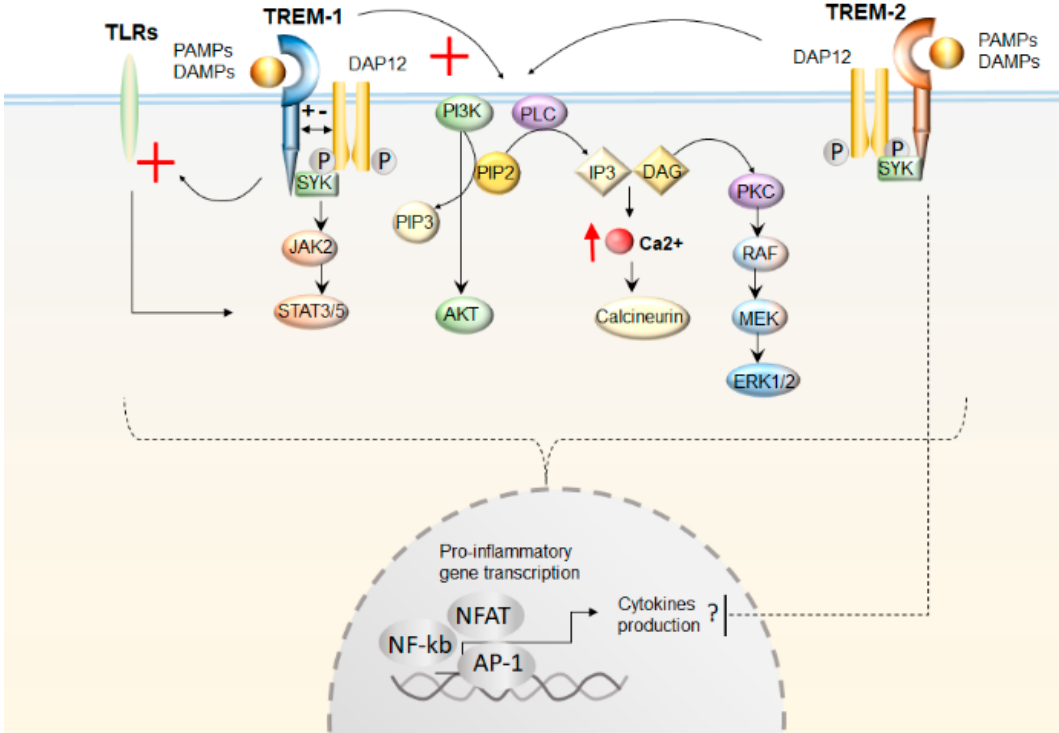
Figure 1. The effects of TREMs (Triggering Receptors Expressed on Myeloid cells) activation upon ligand binding. Both TREM-1 and TREM-2 are activated upon binding of either Pathogen- or Danger- Associated Molecular Patterns (PAMPs and DAMPs, respectively). TREMs activation occurs upon interaction with the 12-kDa DNAX Activating Protein (DAP12) and with the spleen tyrosine kinase (SYK), leading to subsequent stimulation (red cross) of the signaling pathways Janus Kinase/Signal Transducer and Activator of Transcription JAK/STAT, phosphatidylinositol 3-kinase (PI3K)/AKT phospholipase C (PLC), Ca2+/calcineurin, and protein kinase C (PKC)/extracellular-signal-regulated kinase (ERK1/2). TREM-1 also potentiates Toll-like receptors (TLRs) signaling (red cross). Altogether, these cascades converge in activating pro-inflammatory gene transcription through the transcription factors—a nuclear factor of activated T cells (NFAT), activator protein 1 (AP-1), and nuclear factor- κ B (NF- κ B). Contrarily to TREM-1, TREM-2 may inhibit cytokine production, likely by negatively regulating TLRs response, though this is dependent on disease specificity and level of inflammation. PIP2 Phosphatidylinositol 4,5-bisphosphate; PIP3 Phosphatidylinositol (3,4,5)-trisphosphate; IP3 inositol triphosphate; DAG diacylglycerol. Lipopolysaccharide (LPS); High Mobility Group Box 1(HMGB1); Heat Shkock Protein 70; rapidly accelerated fibrosarcoma/mitogen-activated protein kinase kinase (RAF/MEK)